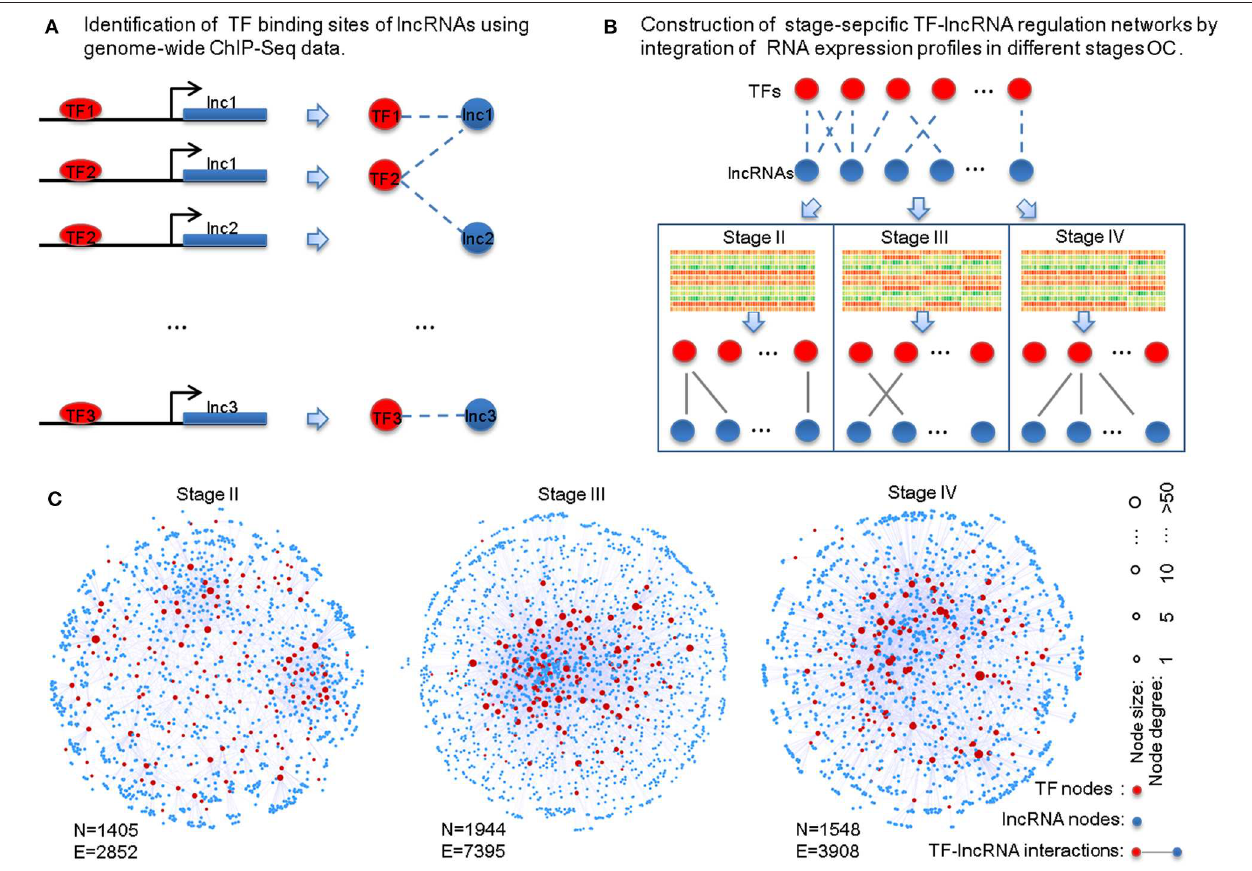
FIGURE 1 | Construction of the stage-specific TF-lncRNA regulatory networks in OC. (A) Identification of conserved transcription factor binding sites on lncRNAs from ChIP-Seq datasets. (B) Identification of stage-specific TF-lncRNA relationships in different OC stages based on co-expression analysis. (C) Network illustration of the three stage-specific TF-lncRNA regulatory networks. N, nodes; E,